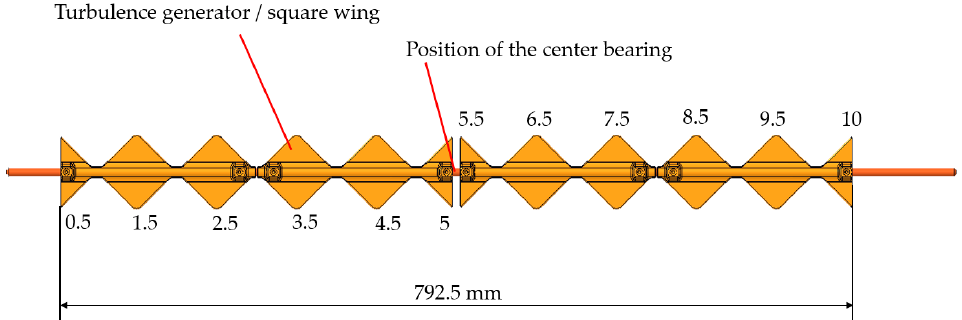
Figure 6. Detail of a single drive shaft with turbulence generators attached.